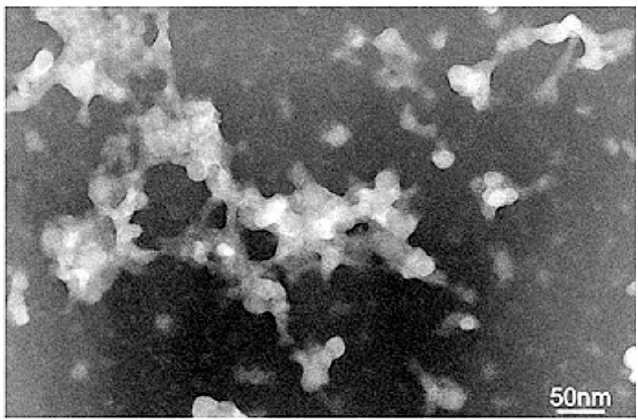
Figure 4. Ultrastructure of ruthenium terminated carbosilane dendrimer with FITC ( CRD13-FITC ). Dendrimer was dissolved in Na-phosphate buffer at 10 mmol/L, and pH7.4. Bar = 50 nm.